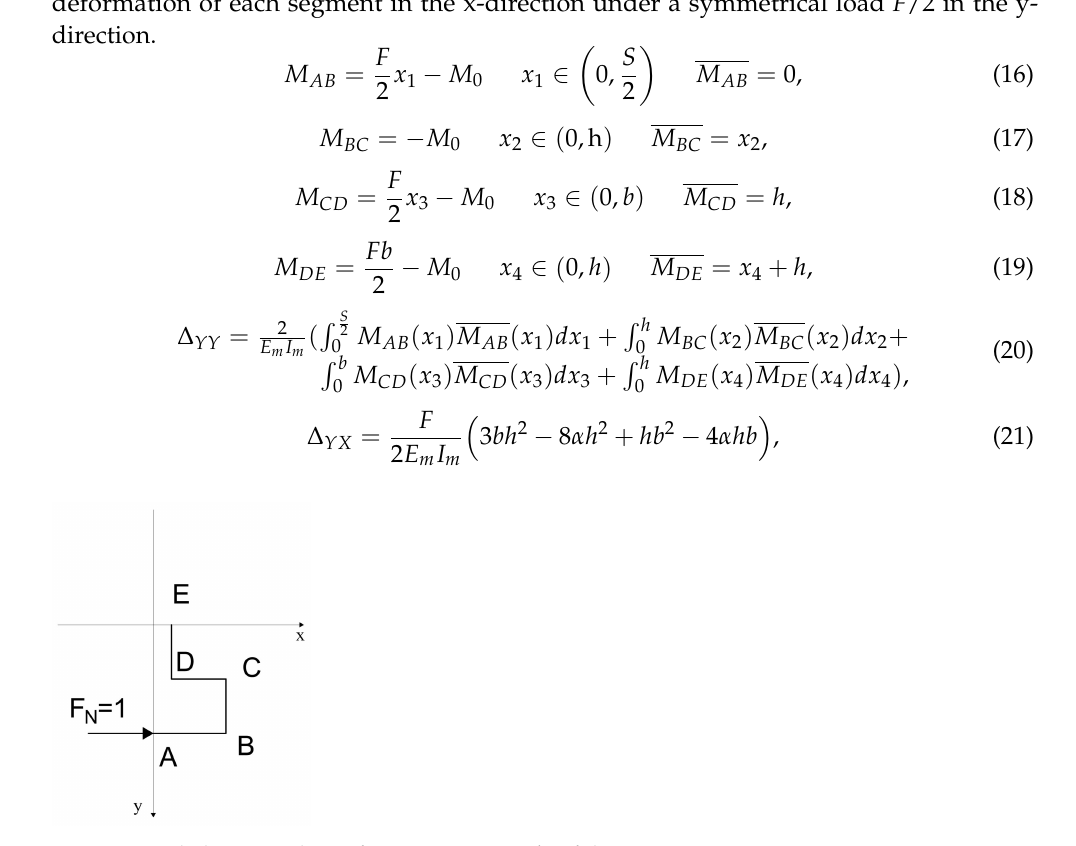
Figure 6. Only horizontal unit forces acting on 1/4 of the